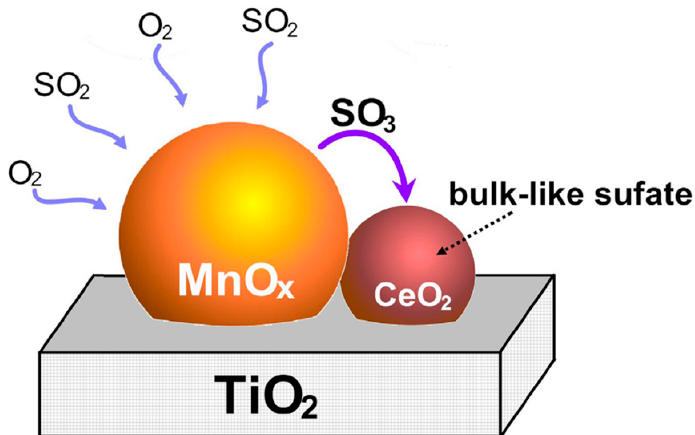
Figure 30. The formation pathway of bulk-like sulfate on Mn-Ce/TiO 2 samples [18].